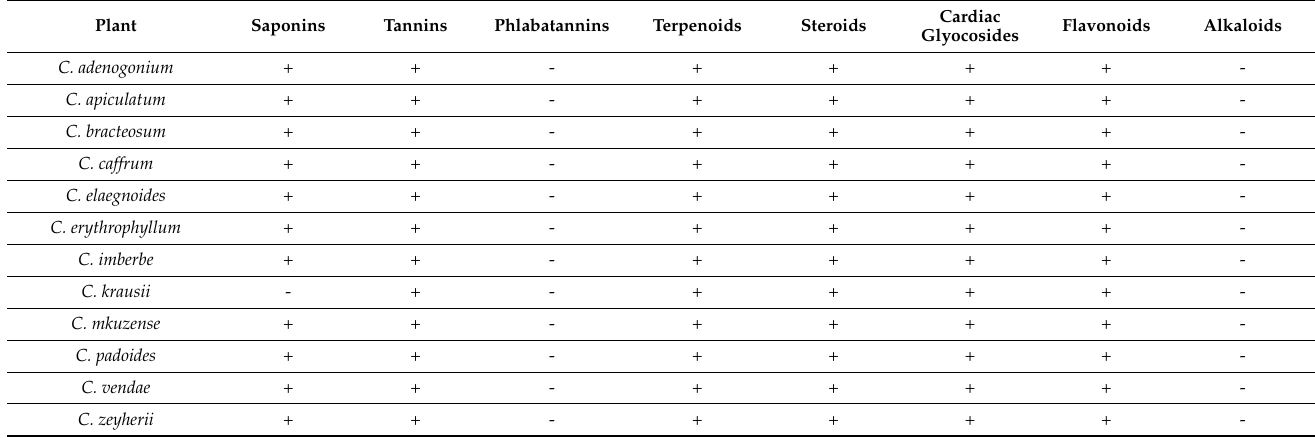
Table 2. Qualitative test for phytochemicals in the leaves.